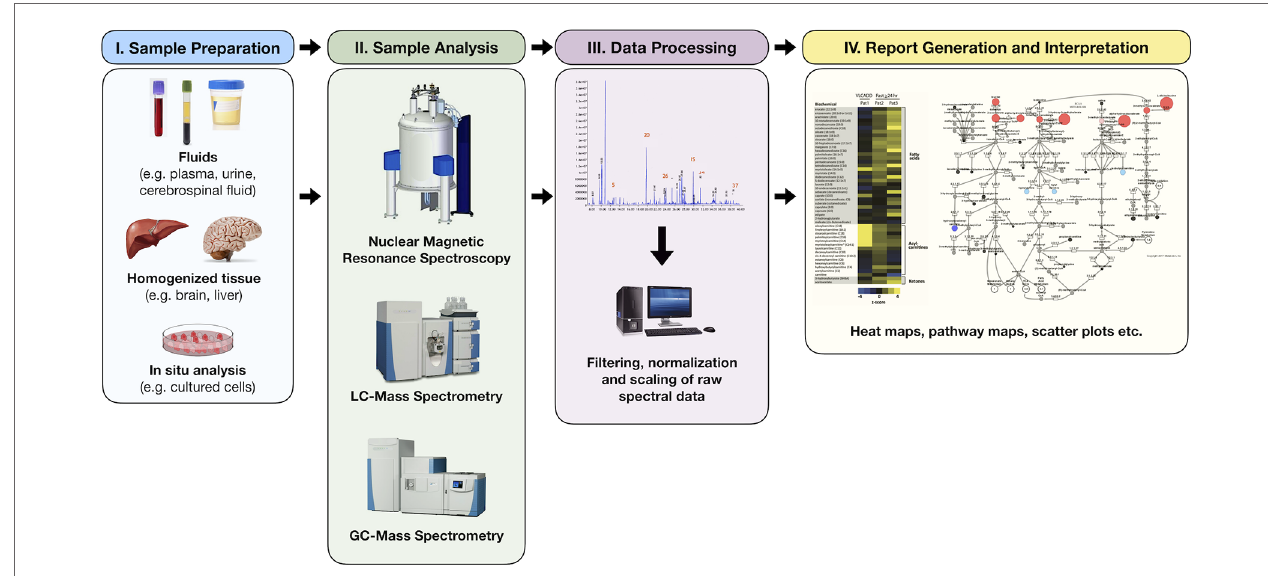
FIGURE 2 | Simplified process of metabolomic profiling. Samples are collected and undergo an initial processing step that may include homogenization and/ or centrifugation. This is followed by analysis via nuclear magnetic resonance or mass spectrometry techniques from which raw spectral data are collected. Raw data are then filtered, normalized, and scaled to ensure that analyte peaks may be accurately interpreted. Chemical compound libraries are utilized for accurate compound identification. The resultant data may then be plotted or reported in a variety of ways including heat maps, pathway enrichment maps, and scatter